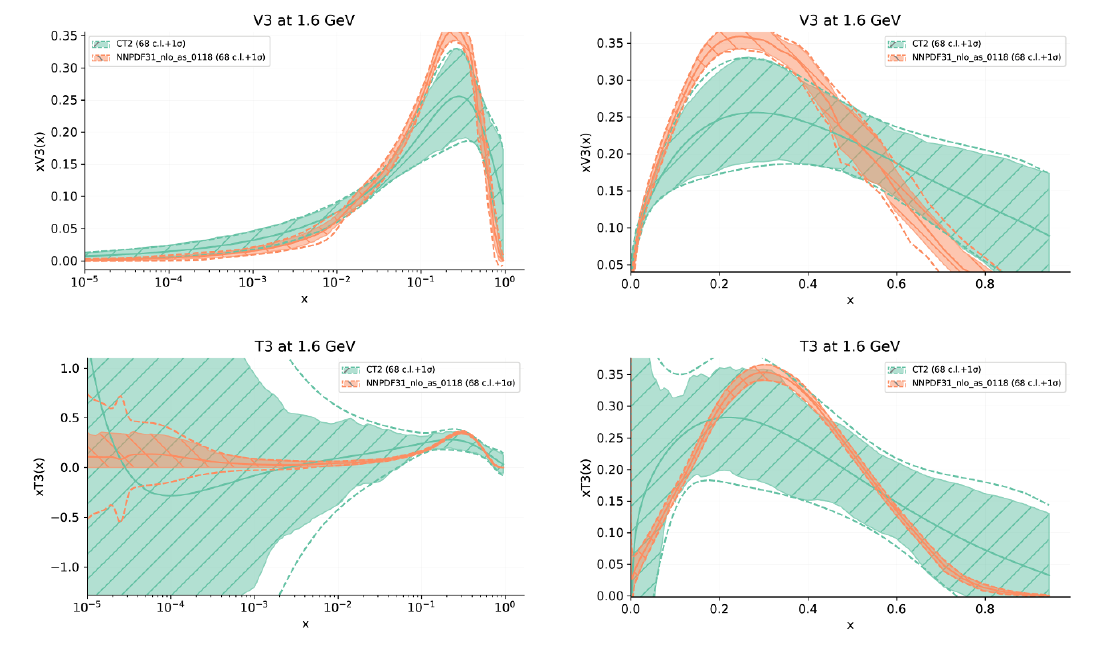
Figure 3 . Closure test (cid:12)t with real statistical error and no systematics (CT2) compared to the input PDFs set. Top line: V 3 combination in linear and logarithmic scale. V 3 (top line) and T 3 (lower line) combinations in linear and logarithmic scale are shown. The error band of the reconstructed set is way bigger than the one of the input PDFs, showing a non negligible impact of the current statistics over the (cid:12)nal PDFs